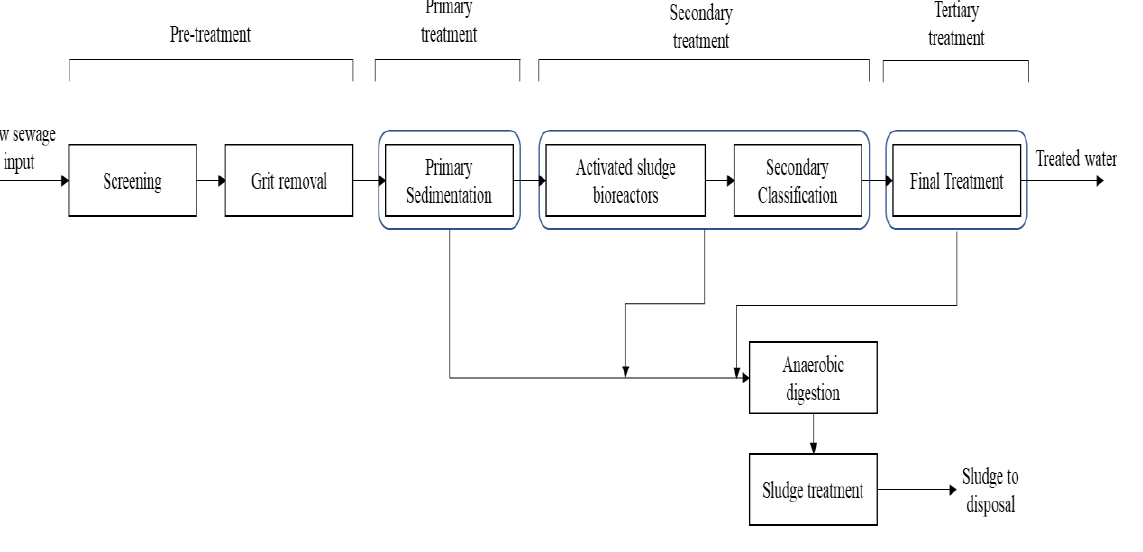
Figure 1. Flow diagram of the WWTP process.